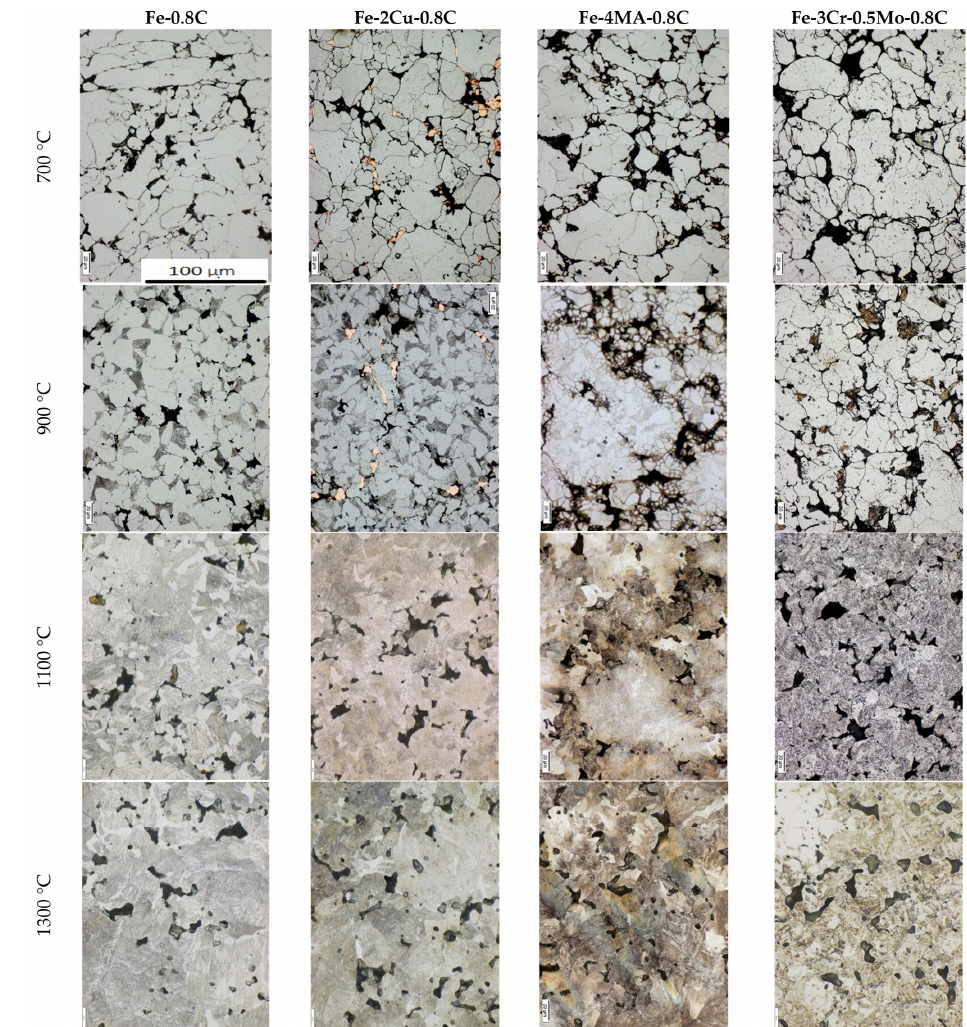
Figure 7. Microstructures of steels sintered 60 min in argon at different temperatures, 500× (scale bar in Figure 6a holds for all images).